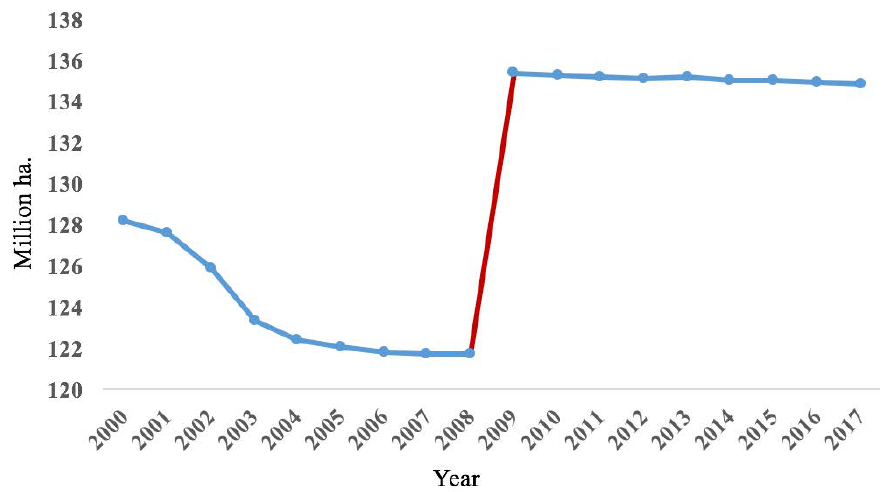
Figure 3. Changes in China’s farmland area between 1996 and 2017, including the adjustments that resulted from the 2007–2009 national land